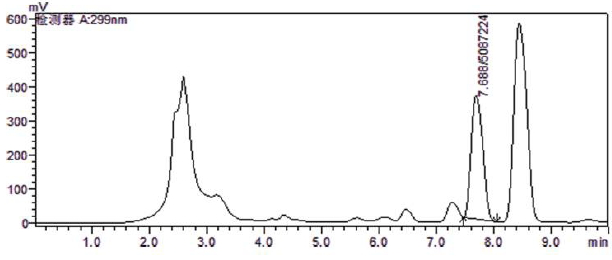
Fig 3. The HPLC Figure of rotenone in acetone extractof Tephrosia vogelii leaves. Table 1 . Determination of rotenone